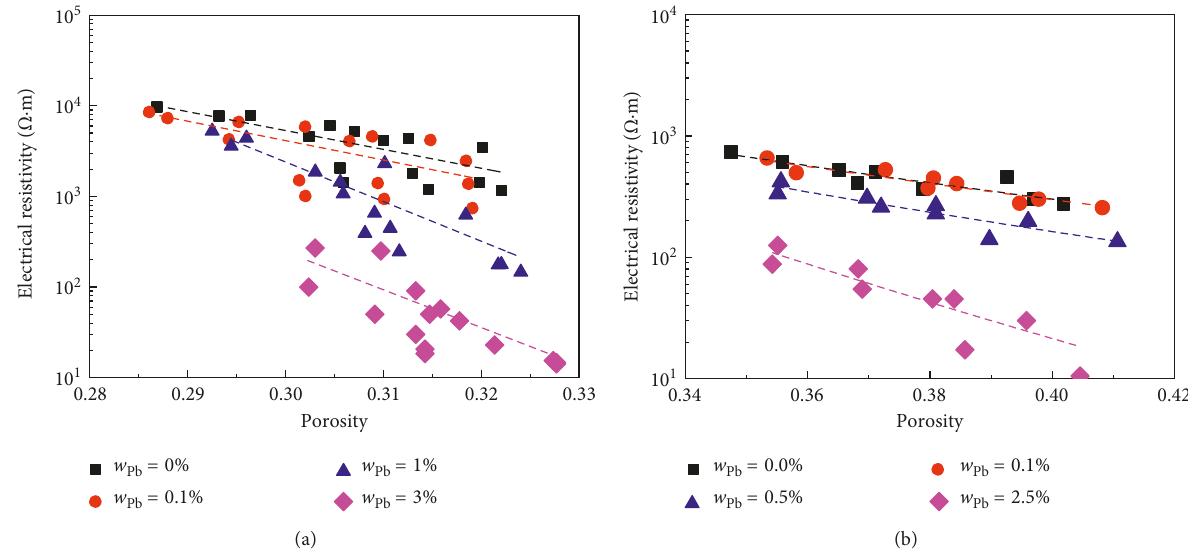
Figure 5: Variation of electrical resistivity with porosity: (a) specimens of soil S1; (b) specimens of soil